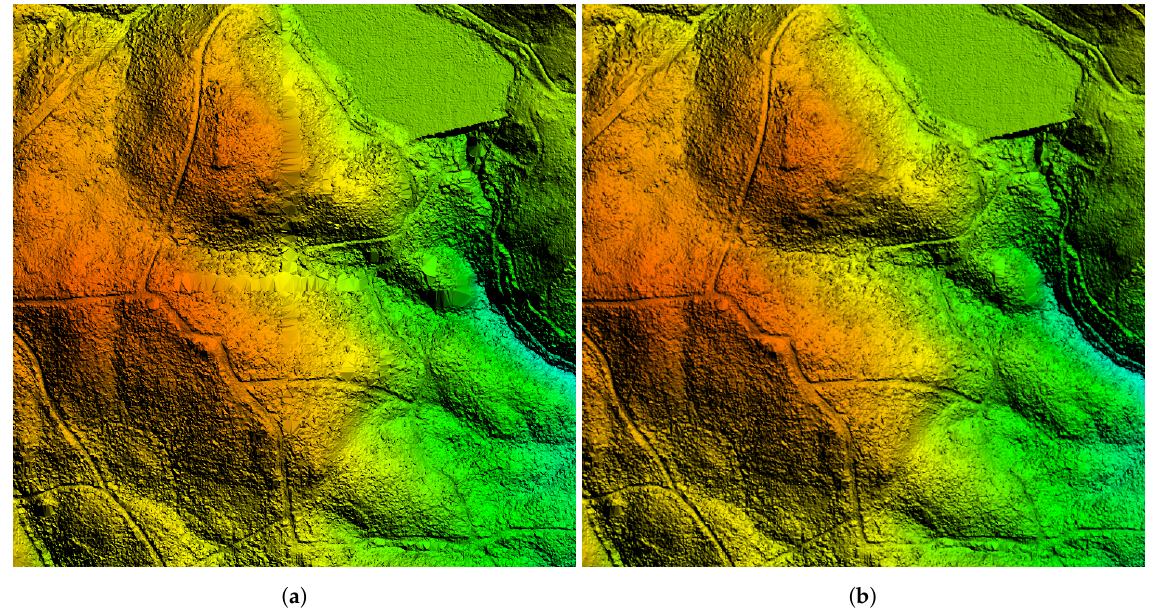
Figure 12. Fully triangulated rasters containing ground points only. Images represent a very close view over an area with four zones (2 × 2 on 1 km 2 ) from the dataset D3. ( a ) (NO-EC) DTM shows artifacts matching the boundaries of the zones. ( b ) (EC) The artifacts are gone once our strategy was